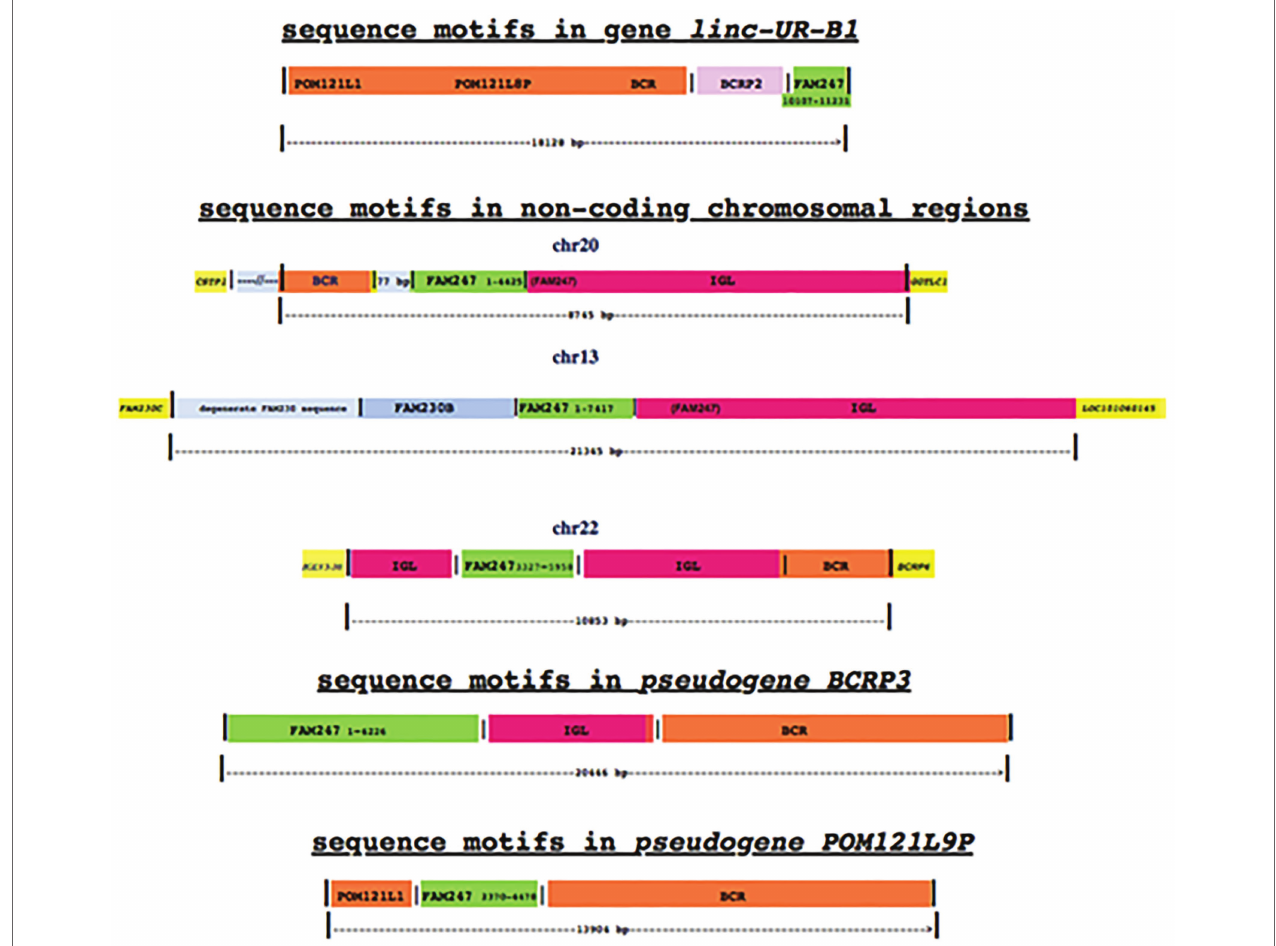
FIGURE 2 | A diagrammatic comparison of non-coding chromosomal loci with linc-UR-B1 and genes that display similar gene/sequence motifs. The numbers next to FAM247 are the bp positions of the FAM247 sequences that are present in each non-coding region and each gene; the segments of the FAM247 sequence that is present in the genes/non-coding regions differ in each example shown. In chr 20, 4,425 bp of FAM247 includes 3,305 bp present in and contiguous with the immunoglobulin lambda (IGL) sequence; in chr 13, the 7,442 bp shown includes 3,298 bp of FAM247 that are also in the IGL sequence. The genes highlighted in yellow flank the non-coding regions and represent guideposts. Supplementary Figures S3A – C provides an analysis of these regions. The POM121L9P and BCRP3 gene structures are from Delihas